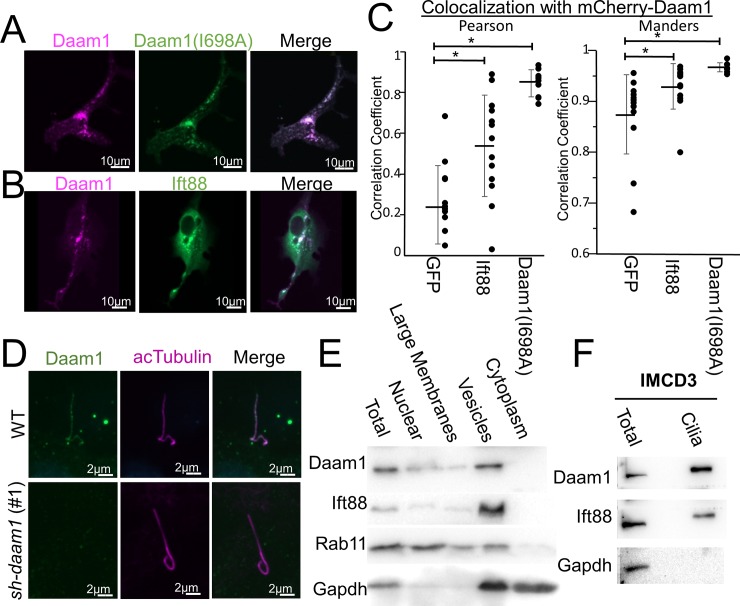
Daam1 localizes to ciliary vesicles and cilia.A) MDCKII cells were co-transfected with constructs that express mCherry-Daam1 and GFP-Daam1(I698A) then imaged via confocal to analyze the localization in live cells. B) MDCKII cells were co-transfected with constructs that express mCherry-Daam1 and Ift88-GFP than imaged via confocal in live cells to determine the subcellular localization. Scale bars equal to 10 μm. C) MCDKII Cells were transfected with mCherry-Daam1 along with GFP, GFP-Ift88, or GFP-Daam1(I698A), then colocalization was measured using both the Pearson and Manders equations. Error bars are shown as ± SD and black dots indicate colocalization value for each cell measured. D) Wildtype and sh-daam1 (#1) cells were cells were ciliated, fixed, then stained for Daam1 (Proteintech) and acTubulin (Sigma). E) MDCKII cells were subconfluently grown then fractionated for subcellular components. “Total” indicates whole cells lysated isolated prior to fractionation. Lysates were ran on Western blot and probed for Daam1, secretory components (Rab11), ciliary vesicles (Ift88), and cytoplasmic + vescular components (GAPDH). F) Cilia was isolated from IMCD3 cells and lysates were ran on a Western blot. “Total” indicates whole cell lysated isolated prior to deciliation. The blot was probed for the Daam1, a ciliary marker Ift88, and a cellular marker GAPDH.